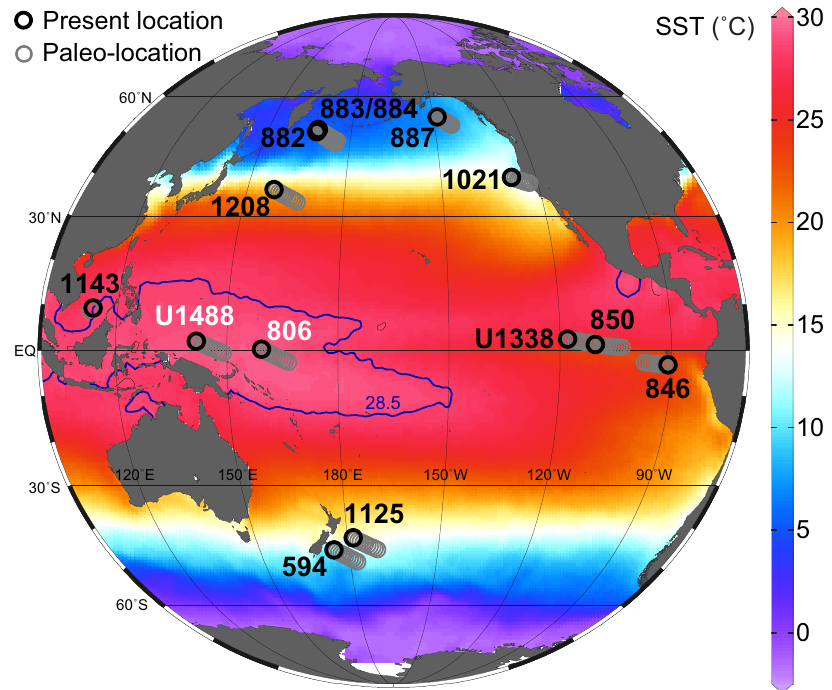
Fig. 1 | Paci fi c sites used in this study. Sites with raw data from this study are labeled in white: International Ocean Discovery Program (IODP) Site U1488 and Ocean Drilling Program (ODP) Site 806. Black labels indicate sites with data obtained from previous studies: IODP Site U1338, ODP Sites 1143, 850, 846, 1208, 1021, 882, 883/884, 887, 1125, and Deep Sea Drilling Project (DSDP) Site 594. Gray circles represent the paleo-locations of each site at a 1-million-year window and